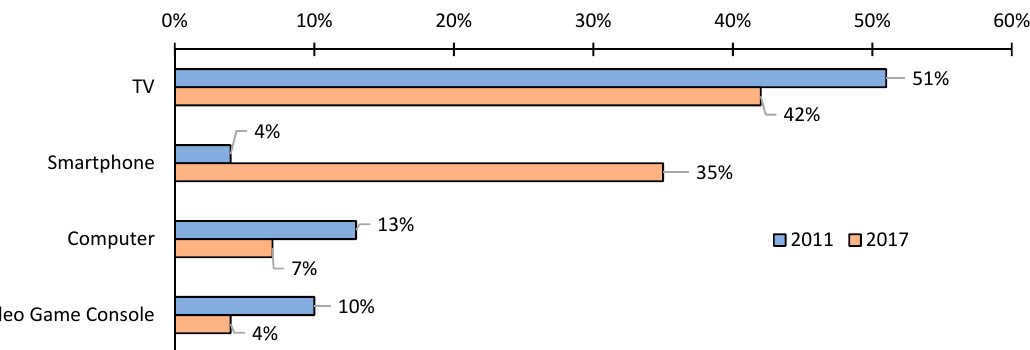
Figure 7. Share of screen time for ages 0–8 years old (%).